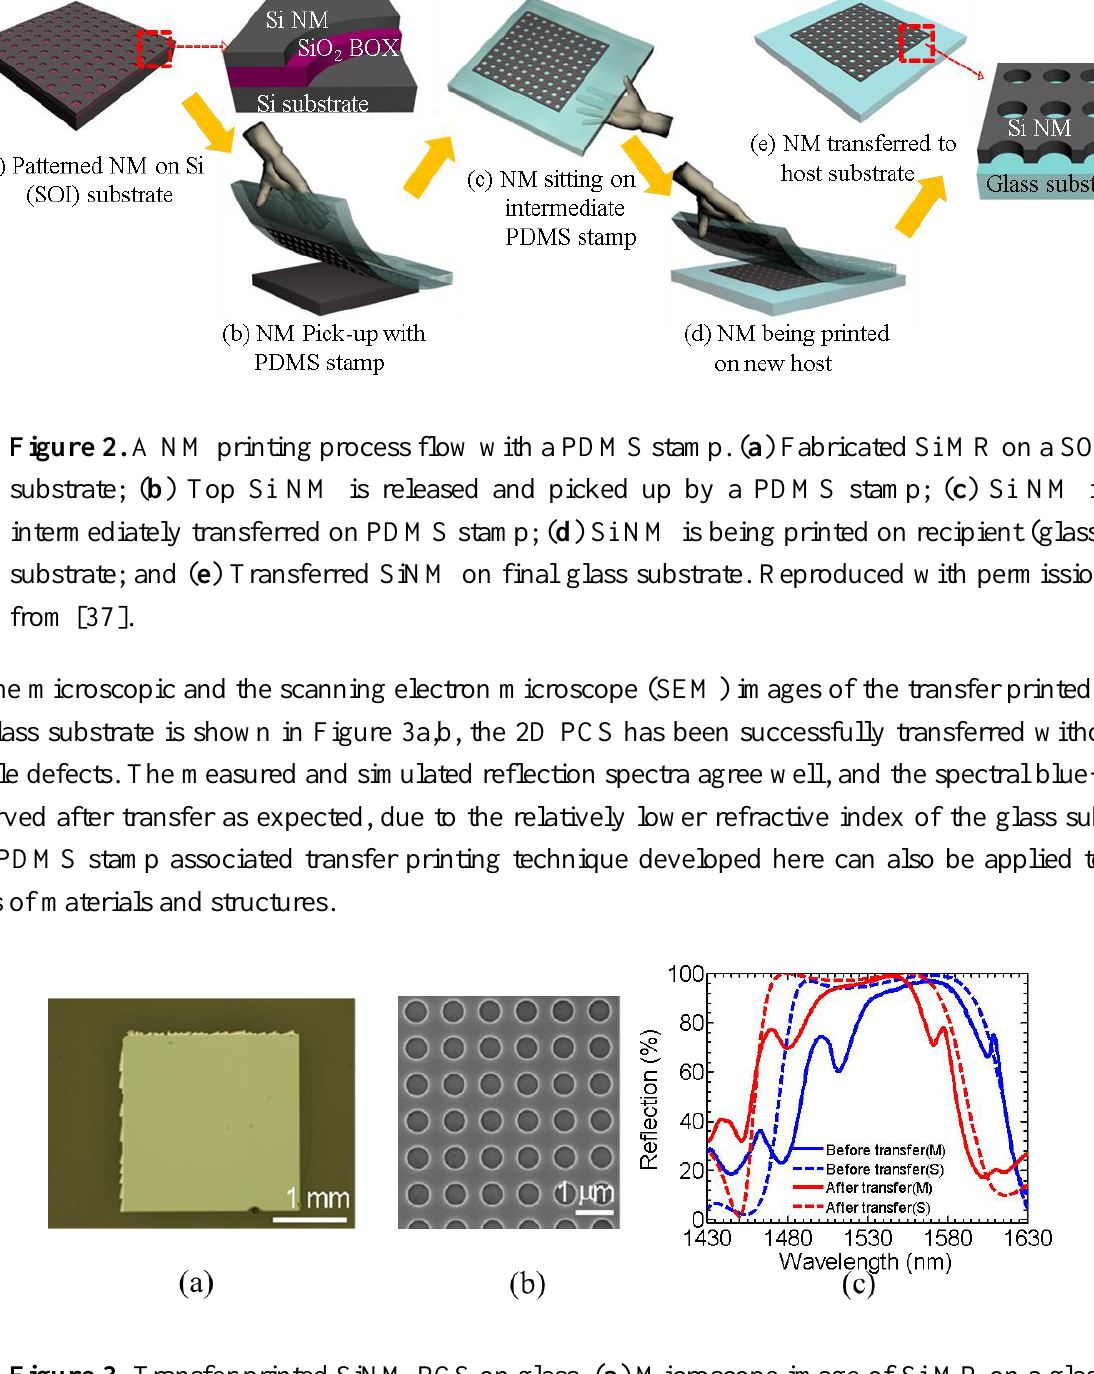
Figure 3. Transfer printed SiNM PCS on glass. ( a ) Microscope image of Si MR on a glass substrate; ( b ) SEM zoom-in image; ( c ) Measured and simulated reflections. Reproduced with permission from